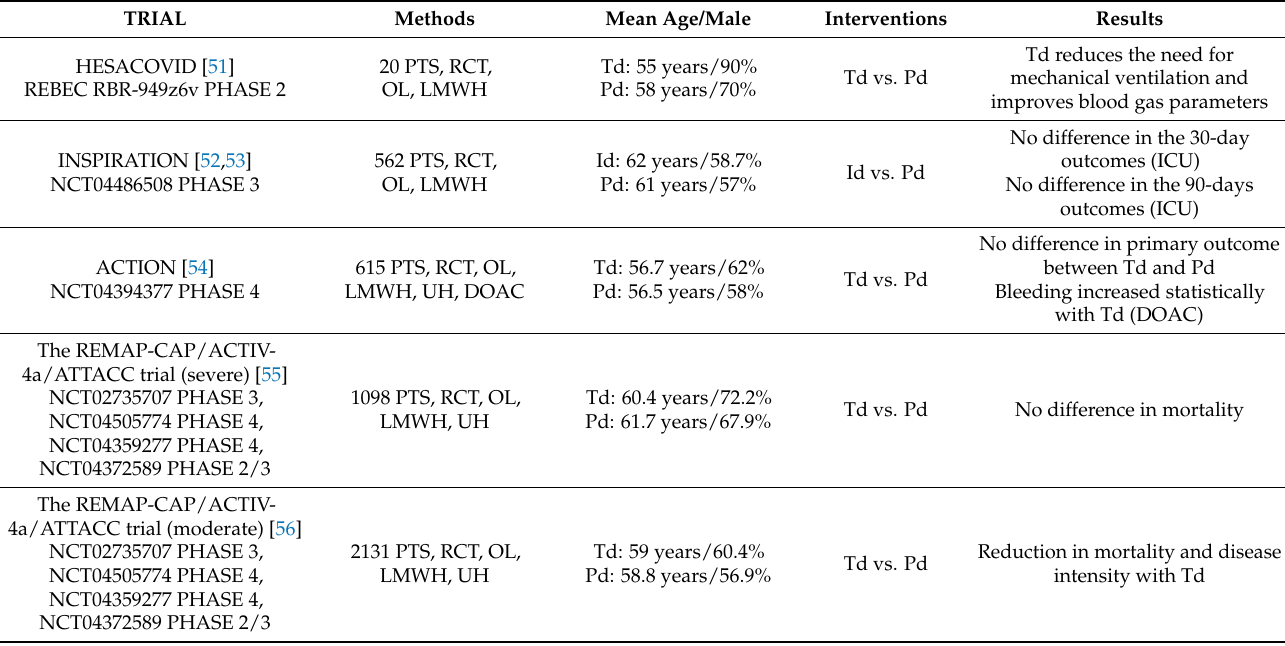
Table 1. Randomized trials on heparin in COVID-19.